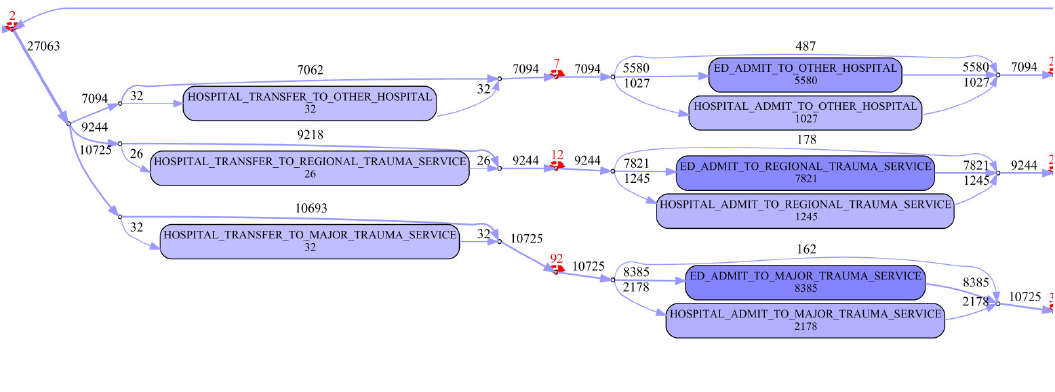
Figure 10. Edited process map fragment (Cohort 3)—trauma service level discharge or transfer to another hospital.